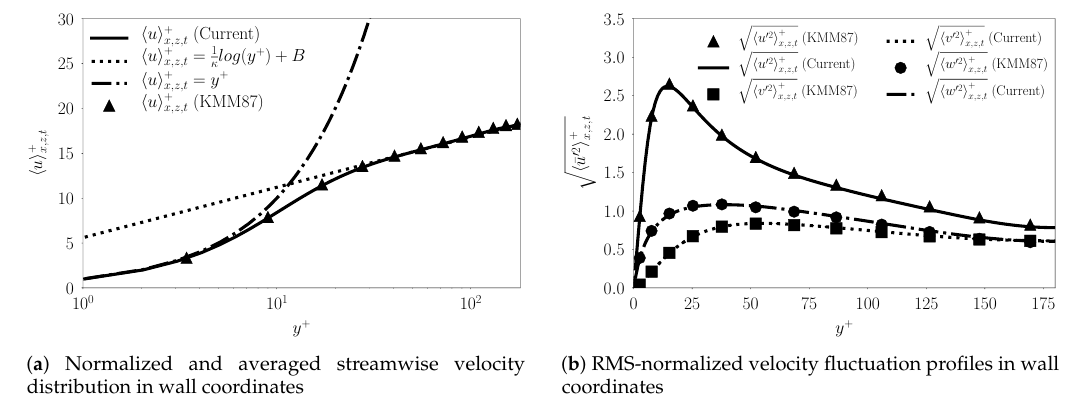
Figure 4. Comparison of mean velocity and RMS velocity fluctuation between DNS of flat channel turbulent flow with IBM and the Kim et al. [39] DNS without